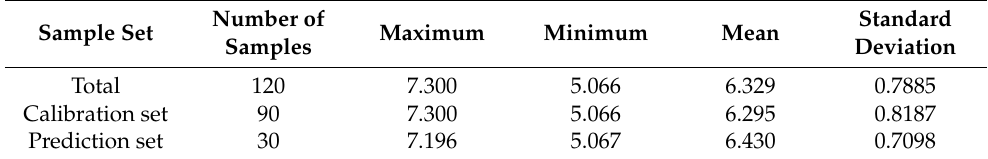
Table 1. Statistics of mango dry matter and sample division results based on SPXY